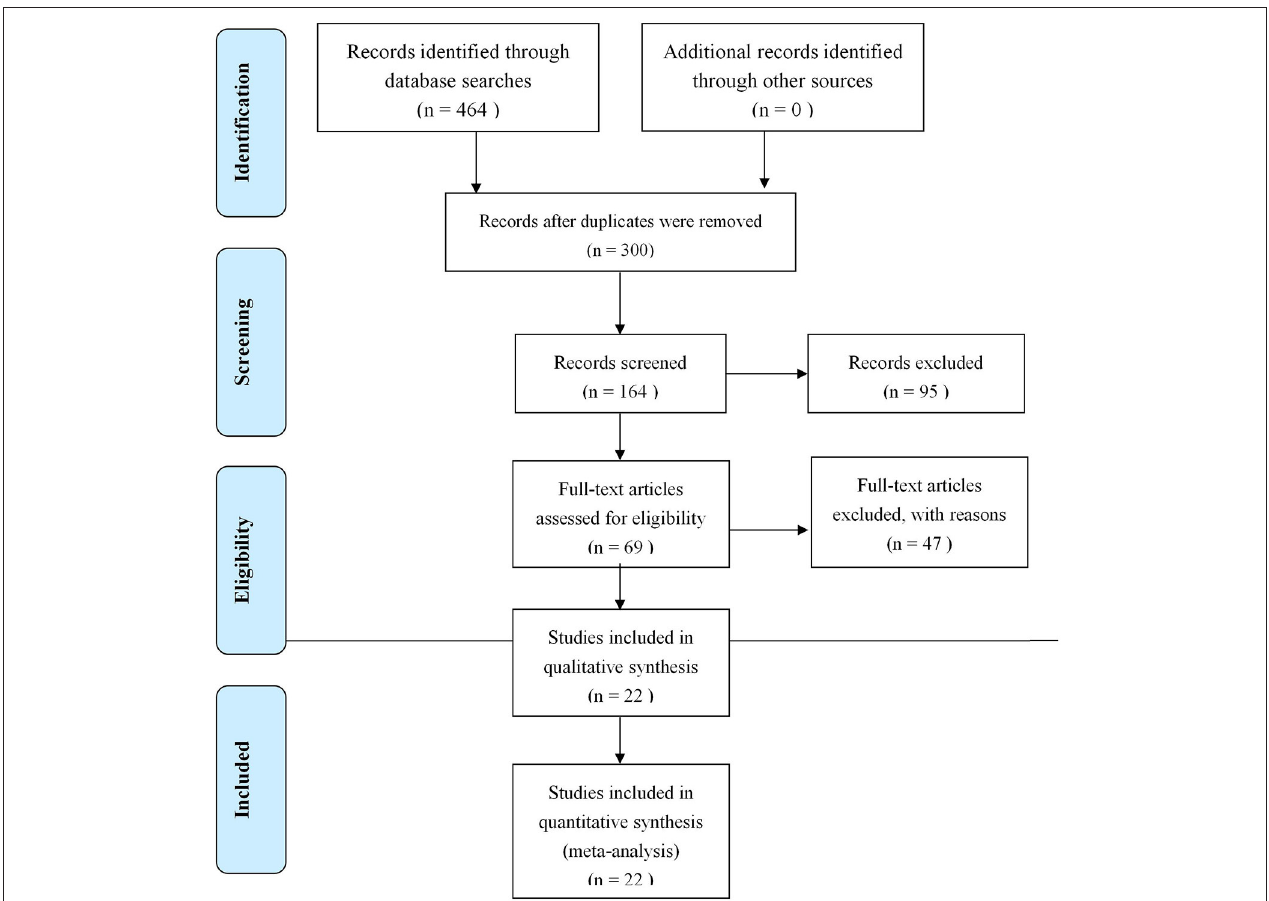
FIGURE 1 | Study Screening Flow